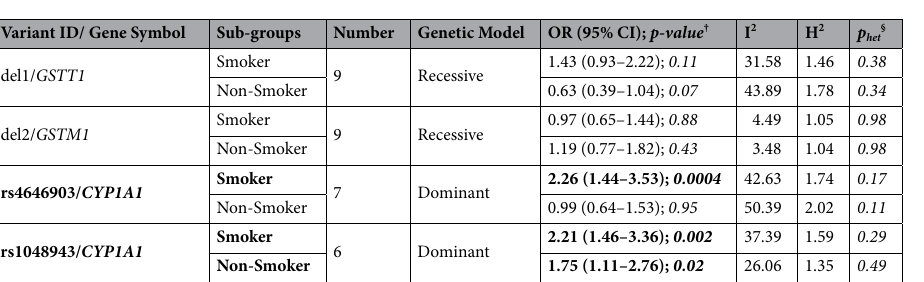
Figure 2. ( A ) Forest plot depicting the odds ratios (ORs), and 95% CI of the polymorphism, del1/ GSTT1 for its association with lung adenocarcinoma in a recessive model in the Indian subcontinent, ( B ) Forest plot depicting the odds ratios (ORs), and 95% CI of the polymorphism, rs4646903/ CYP1A1 for its association with squamous cell carcinoma in a dominant model in the Indian subcontinent, ( C ) Forest plot depicting the odds ratios (ORs), and 95% CI of the polymorphism, rs1048943/ CYP1A1 for its association with adenocarcinoma in a dominant model in the Indian subcontinent, and ( C’ ) Forest plot depicting the odds ratios (ORs), and 95% CI of the polymorphism, rs1048943/ CYP1A1 for its association with squamous cell carcinoma in a dominant model in the Indian subcontinent. ( A – C ) are the representation of the analysis in the FE-model, while ( C’ ) are in RE-model. The forest plots of the significant associations were given ( p < 0.05*). The figures were generated in the ‘metafor’ package (http:// www. metaf or- proje ct. org) of R software (https:// cran.r- proje ct. org/).